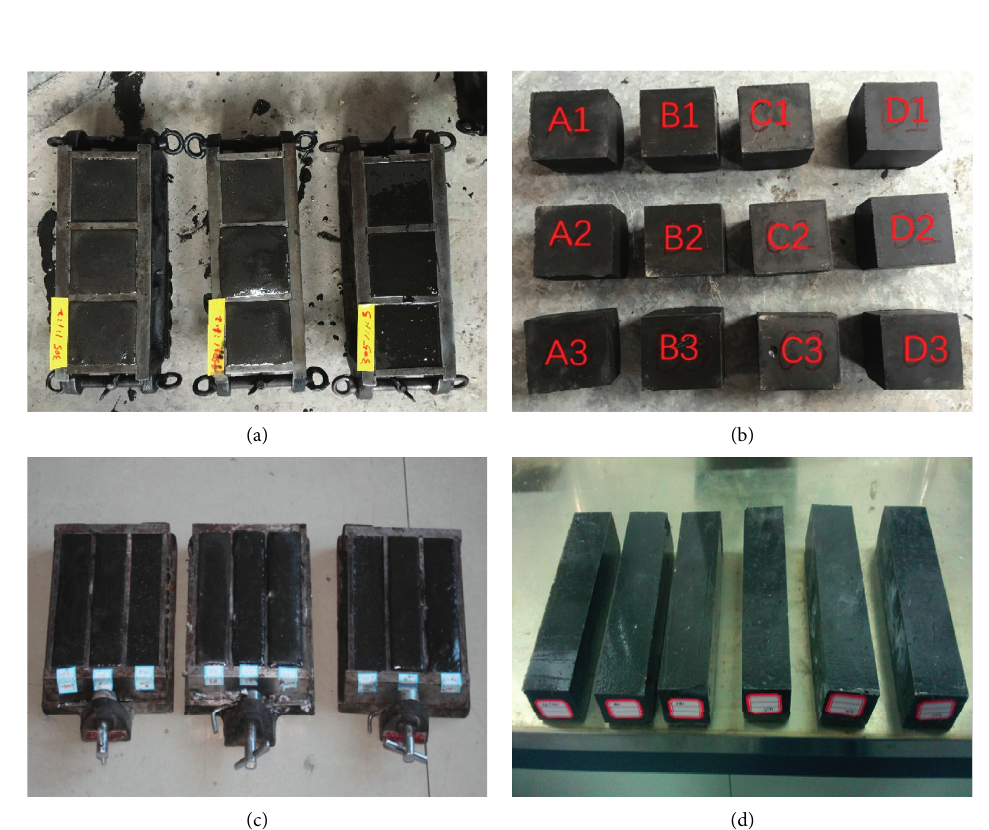
Figure 6: Preparation of polyurethane cement specimens: (a) pouring and curing of compressive specimens, (b) demoulding and numbering of compressive specimens, (c) pouring and curing of flexural specimens, and (d) demoulding and numbering of flexural